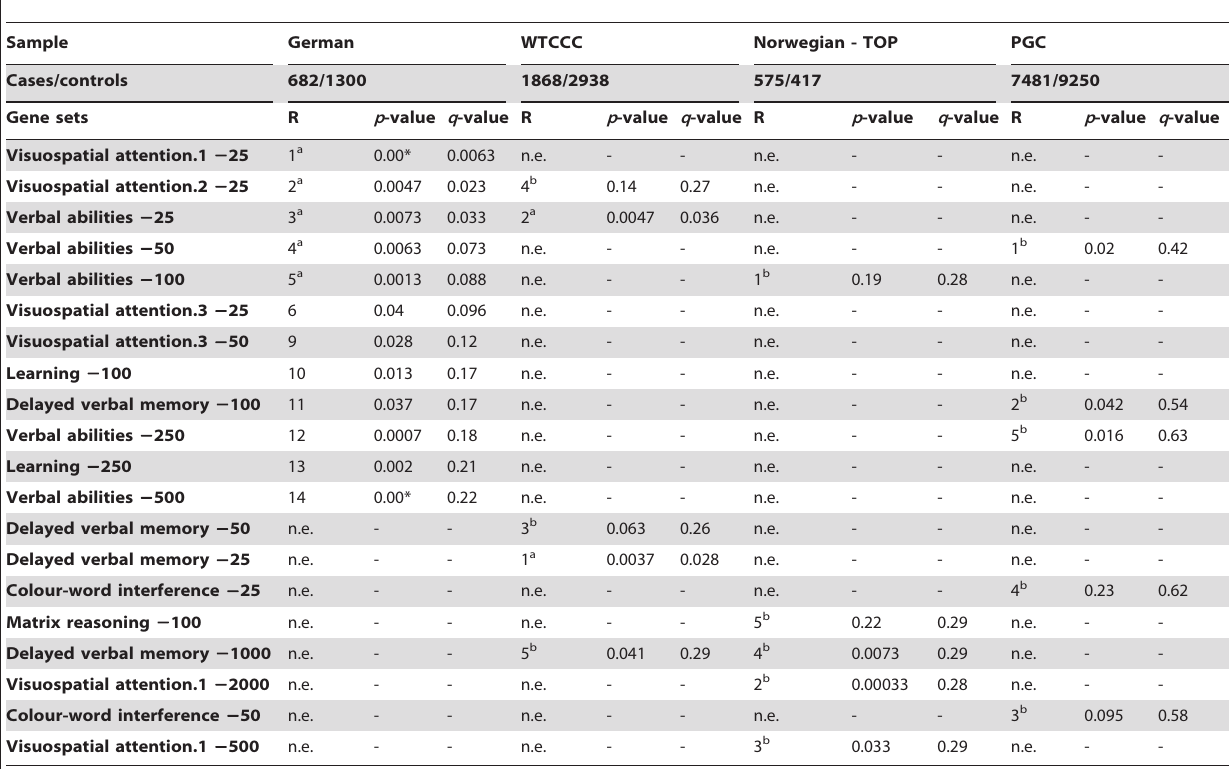
Table 2. Testing gene sets associated with normal neurocognitive variation for enrichment of association with bipolar disorder.